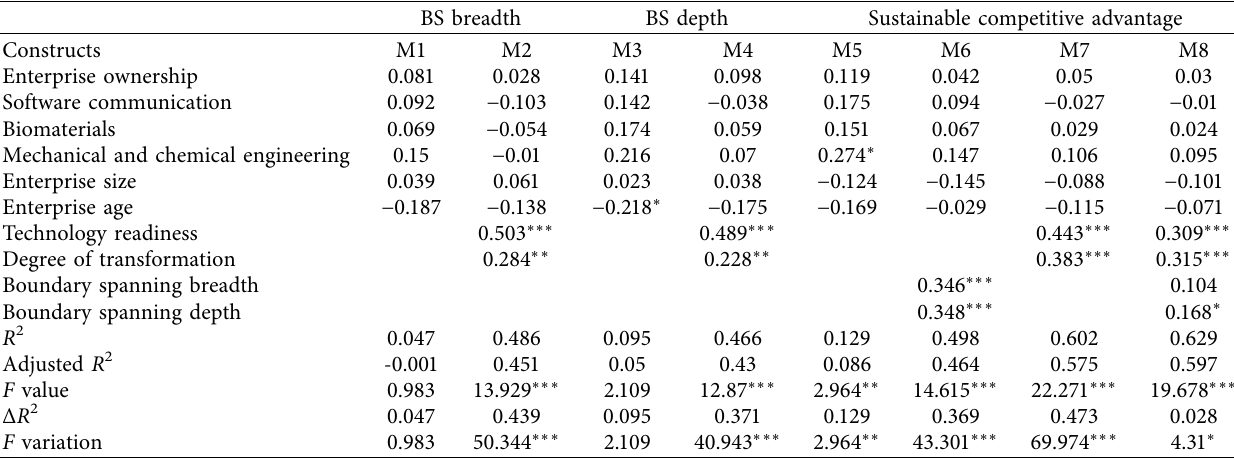
Table 5: Results of hierarchical regression analysis. BS